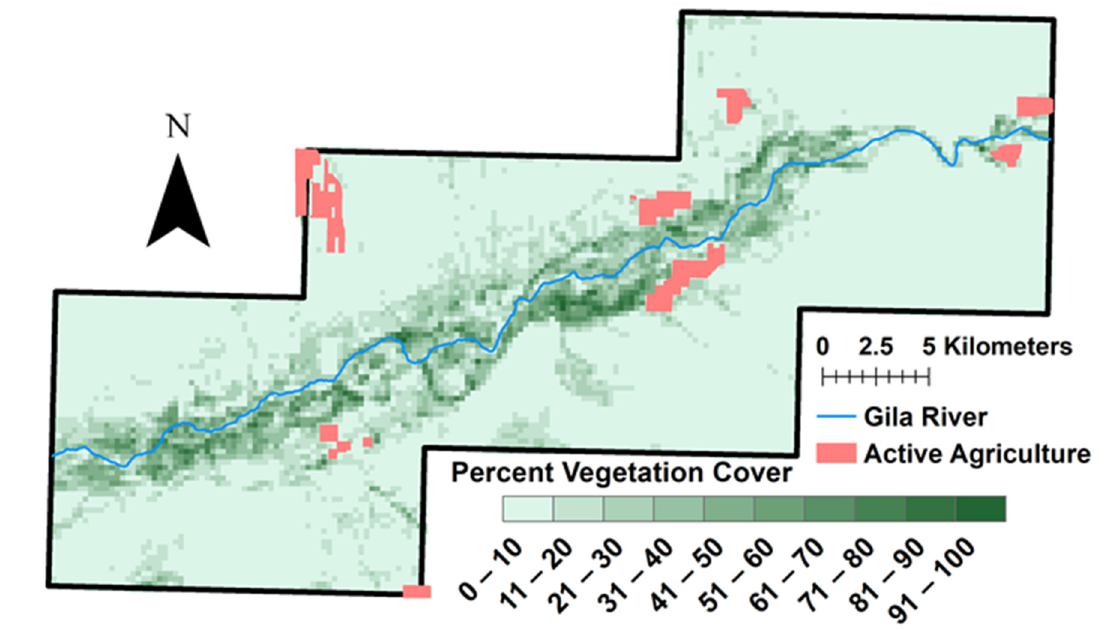
Figure A2. Percent Vegetation Cover 2007. 250 m tessellation of vegetation cover in 2007. Areas with less cover are shown in light green and areas with greater cover are shown in dark green. Areas of active agriculture are shown in pink.